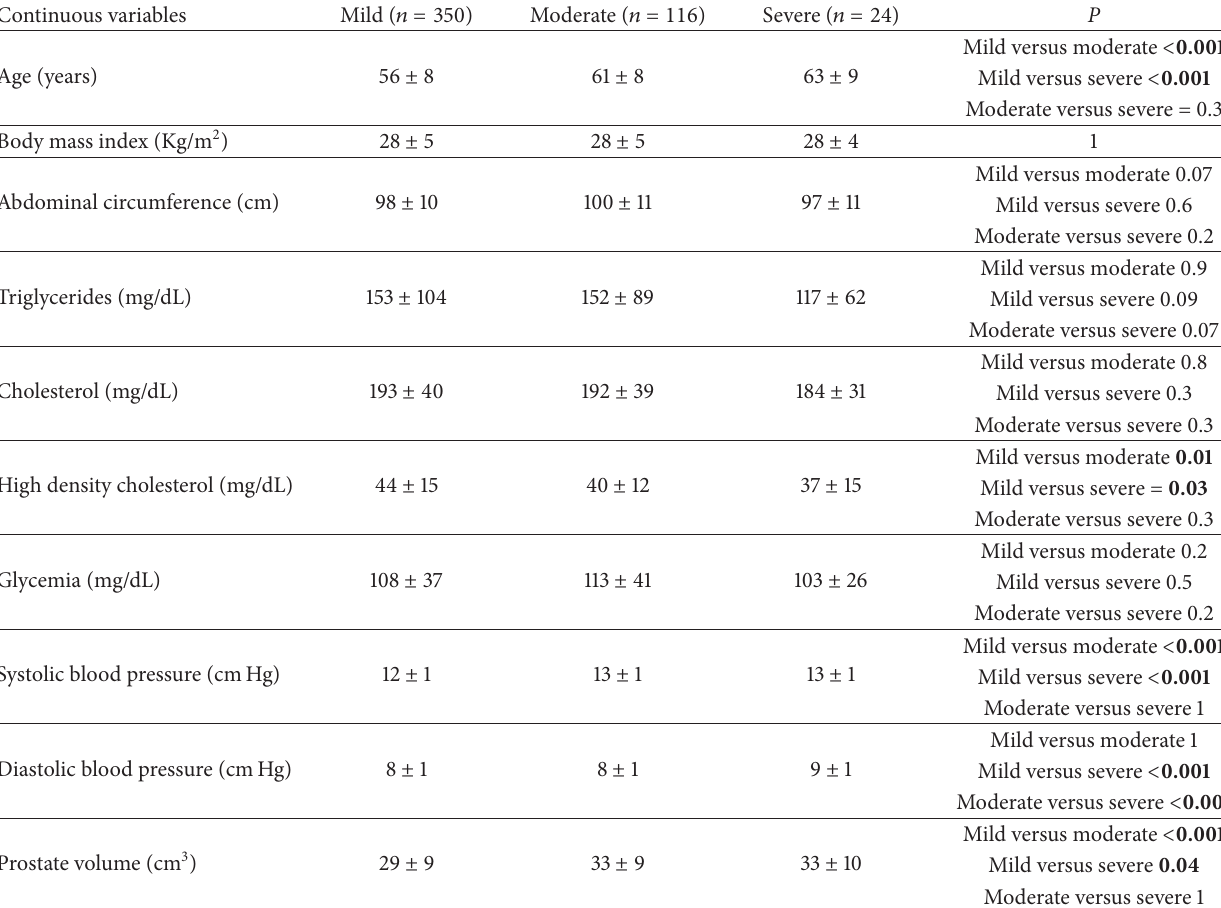
Table 2: Demographic and metabolic parameters of patients according to lower urinary tract symptoms (IPSS).